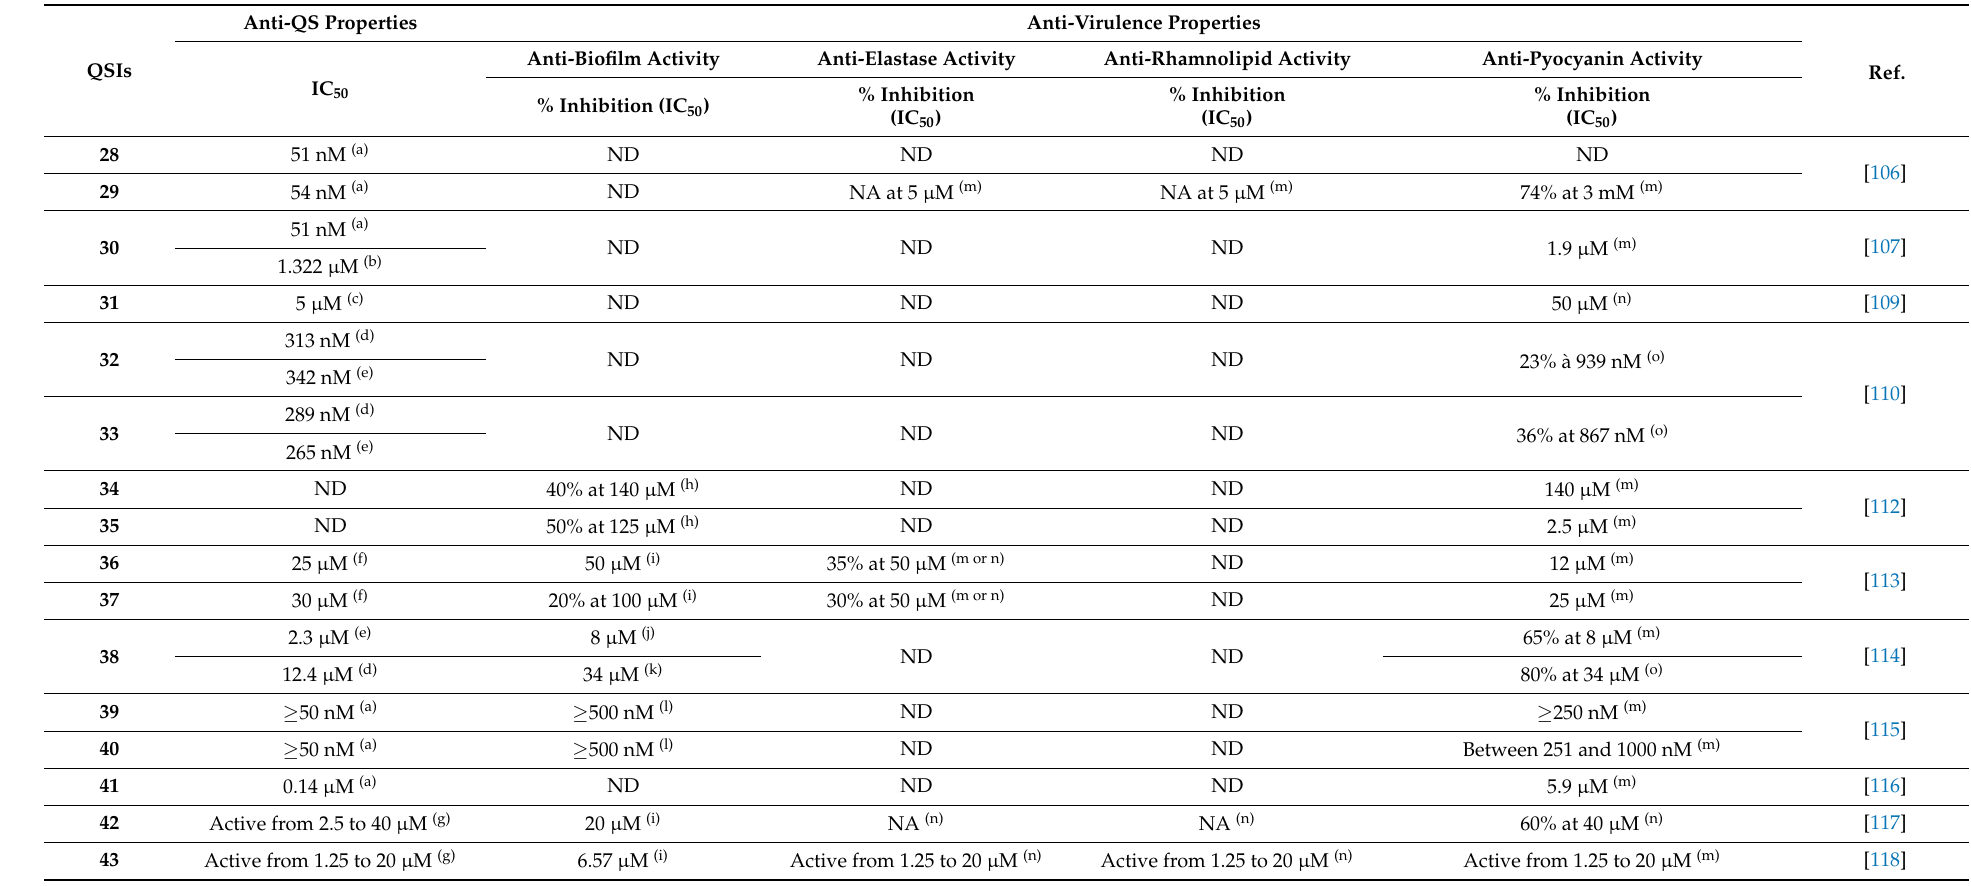
Table 4. Anti-QS and anti-virulence properties of AQ autoinducer analog